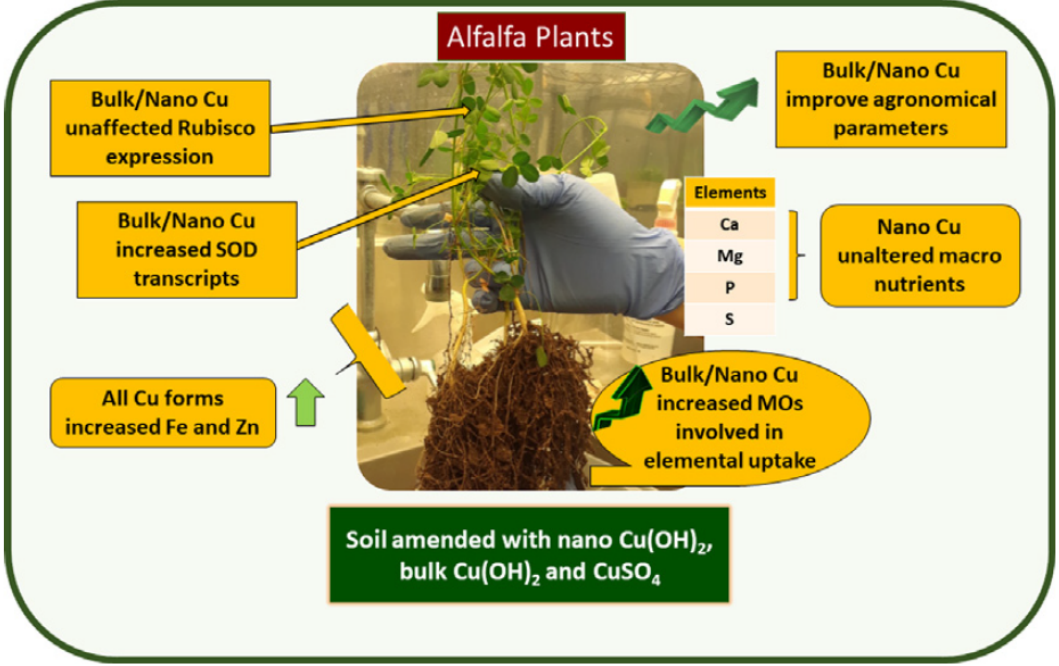
Figure 4. Alfalfa (Medicago sativa) in potting mix amended with bulk, nano, and ionic copper compounds at 80 and 280 mg Cu/kg. Reproduced with permission from [36]. Elsevier, 2020.